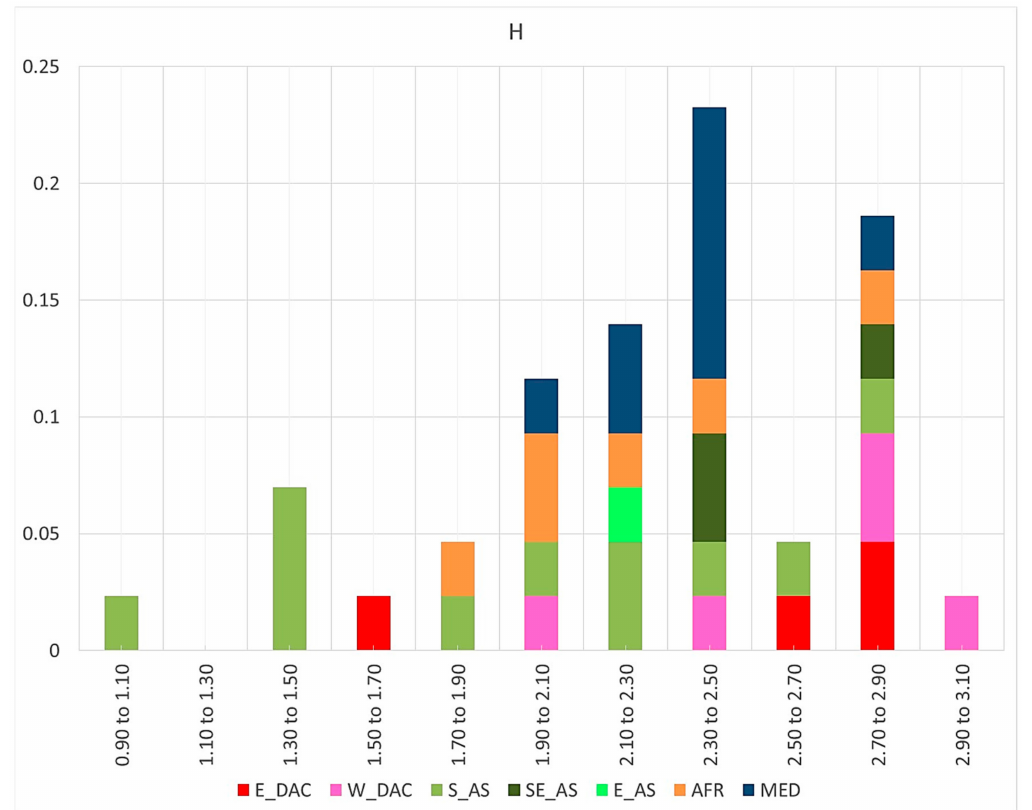
Figure 9. Probability distribution of Phoenix heterogeneity considering large geographical groups. Notice: Abbreviations for the geographical groups: E_DAC: North Africa and West Asia P. dactylifera .